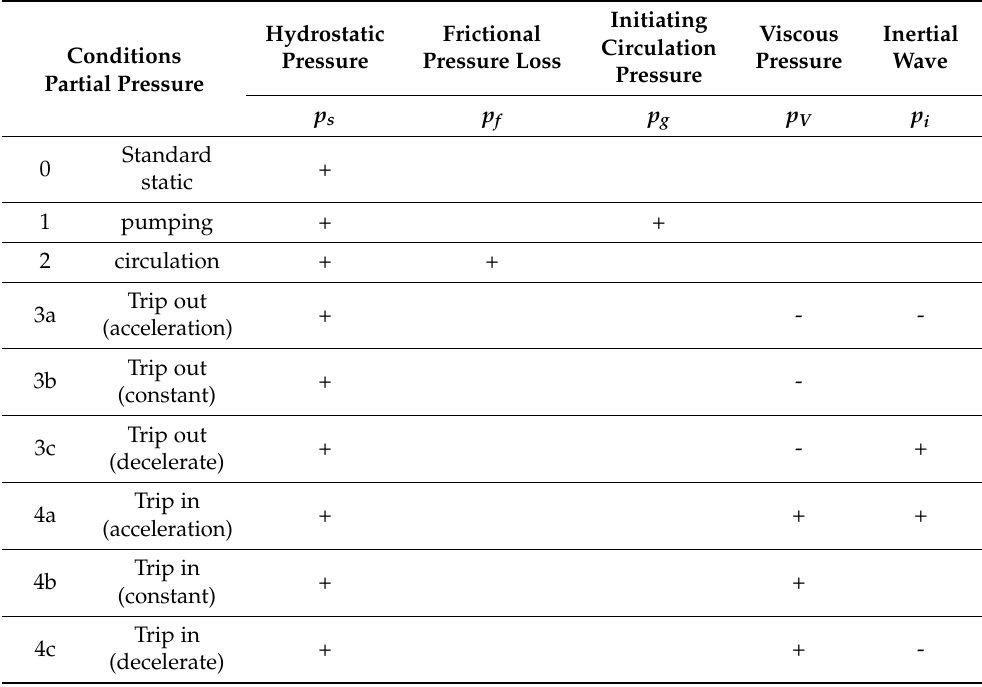
Table 1. The pressure combination in different condition